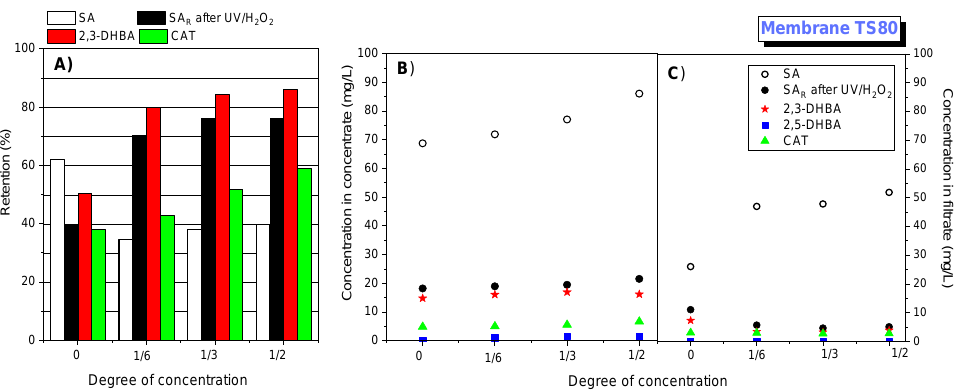
Figure 5. ( A ) Dependence of retention on the degree of initial bath concentration; ( B ) dependence of concentration of salicylic acid and products of its oxidation in the concentrate on the degree of initial bath concentration; ( C ) dependence of the concentration of salicylic acid and products of its oxidation in the filtrate on the degree of initial bath concentration; TS80 membrane, pressure 1.0 MPa, temperature 30 °C. Abbreviations: SA- salicylic acid; 2,3-DHBA- 2,3-dihydroxybenzoic acid; 2,5-DHBA- 2,5-dihydroxybenzoic acid; CAT- catechol; SA R -residual salicylic acid after UV/H 2 O 2 .